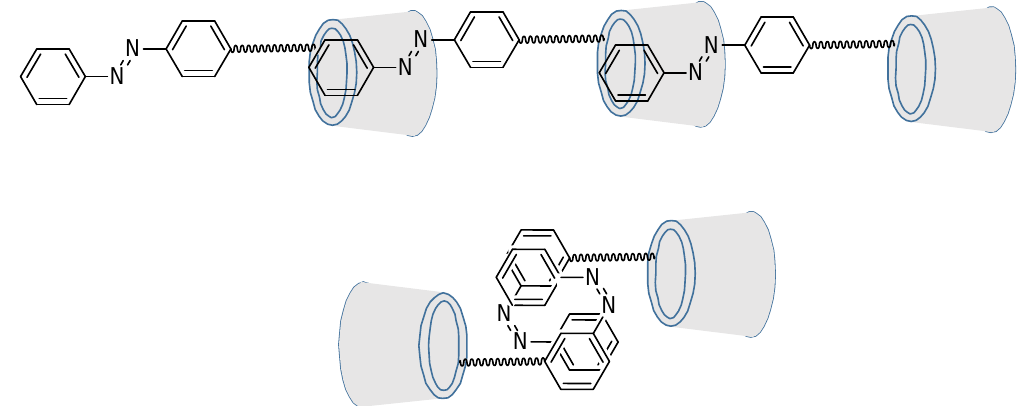
Figure 25. Schematic assembling of trans and cis molecules.